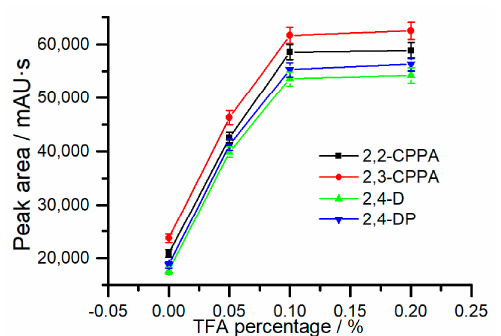
Figure 4. Effect of the trifluoroacetic acid (TFA) percentage in the sampling solution on the extraction efficiencies of the analytes.